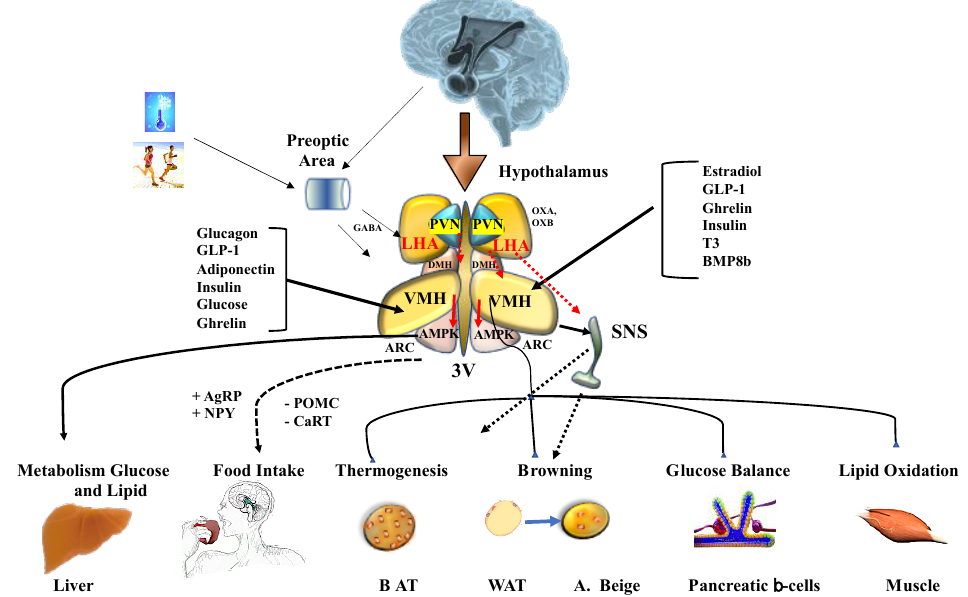
Figure 1. Energy homeostasis controlled by hypothalamus. Cold and physical peripheral signals reach the central nervous system where they interact with their specific receptors in the preoptic area. Adenine monophosphate activated protein kinase (AMPK) can regulate food intake, liver glucose production, lipid metabolism, brown adipose tissue thermogenesis (BAT), white adipose tissue (WAT) browning, and lipid and glycogen synthesis in skeletal muscle. AMPK activity in peripheral tissues is mediated by the activity of the sympathetic nervous system (SNS). Abbreviations: 3V, third ventricle; AgRP, agouti-related peptide; ARC, arcuate nucleus of the hypothalamus; BMP8b, bone morphogenetic protein 8B; CART, cocaine and amphetamine-regulated transcript; DMH, dorsomedial nucleus of the hypothalamus; GLP-1, glucagon-like peptide-1; LHA, lateral hypothalamic area; NPY, neuropeptide Y; POMC: pro-opiomelanocortin; PVN, paraventricular nucleus of the hypothalamus; T3, 3,3′,5-triiodothyronine; VMH, ventromedial nucleus of the hypothalamus. (+) increase intake; (-) reduce intake.